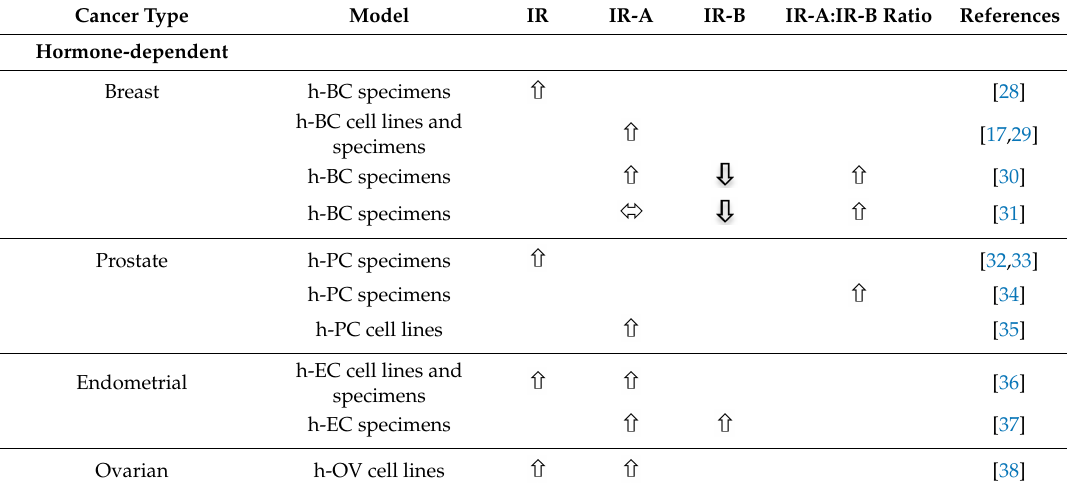
Table 1. Insulin receptor and insulin receptor isoforms expression in various cancer types in comparison with non-malignant paired